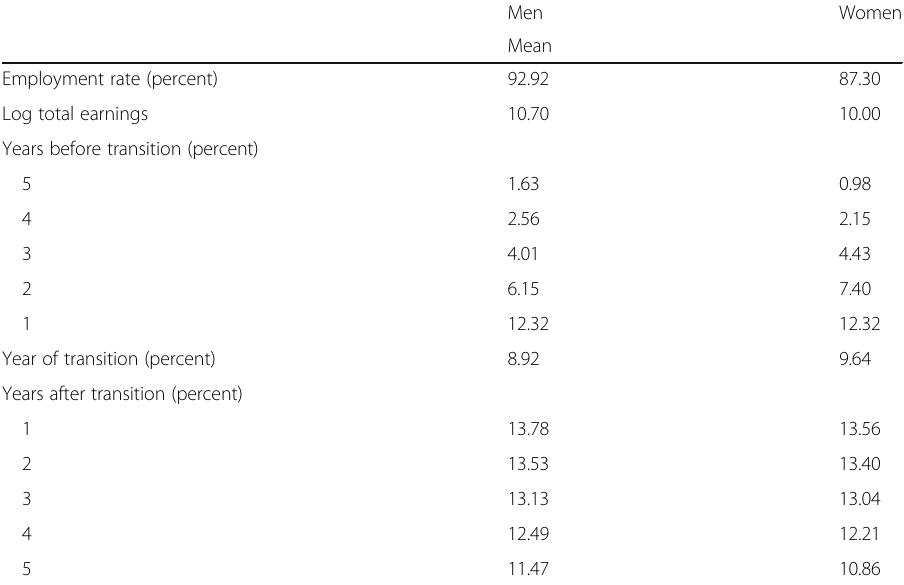
Table 2 Descriptive statistics and sample distributions, by year of observation, 1996 to 2012